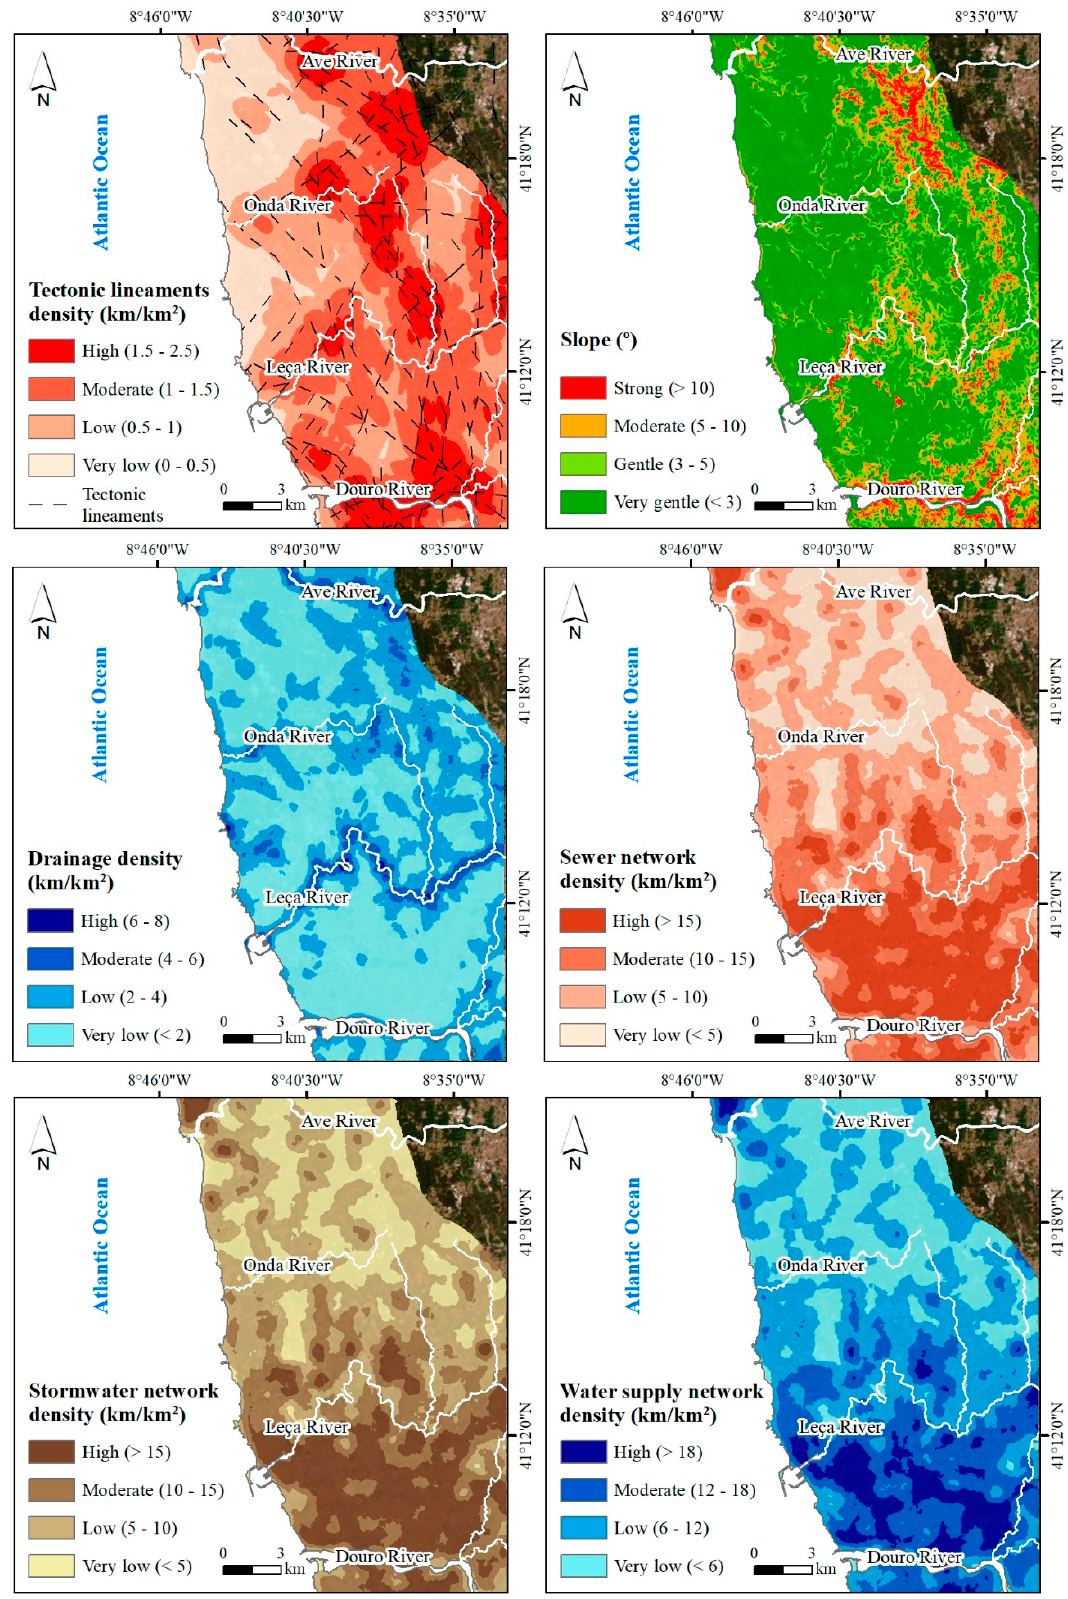
Figure 7. Tectonic lineaments density, slope, drainage density, sewage network density, stormwater network density, and water supply system density in the Porto urban region (NW Portugal).